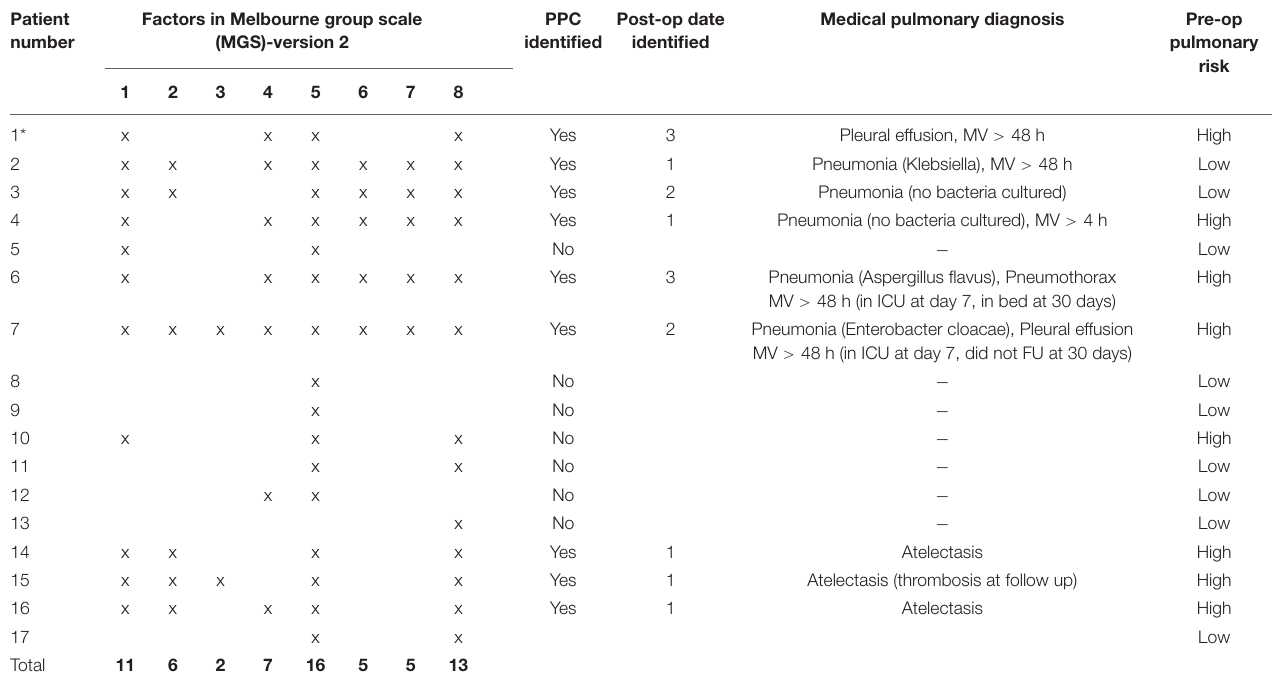
TABLE 3 | Identification of pulmonary complications using the MGS-ver 2 in patients after TTVI. Patient